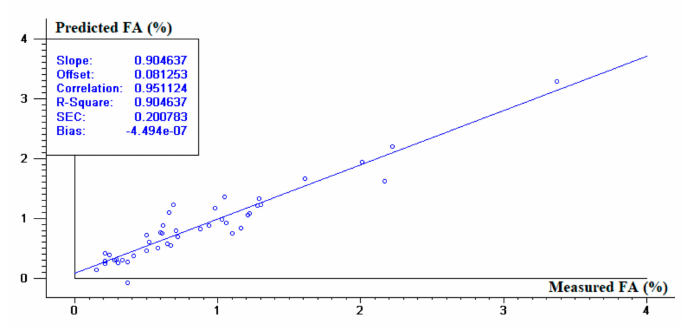
Figure 5. Performance of the 950–1650 PLS model for FA